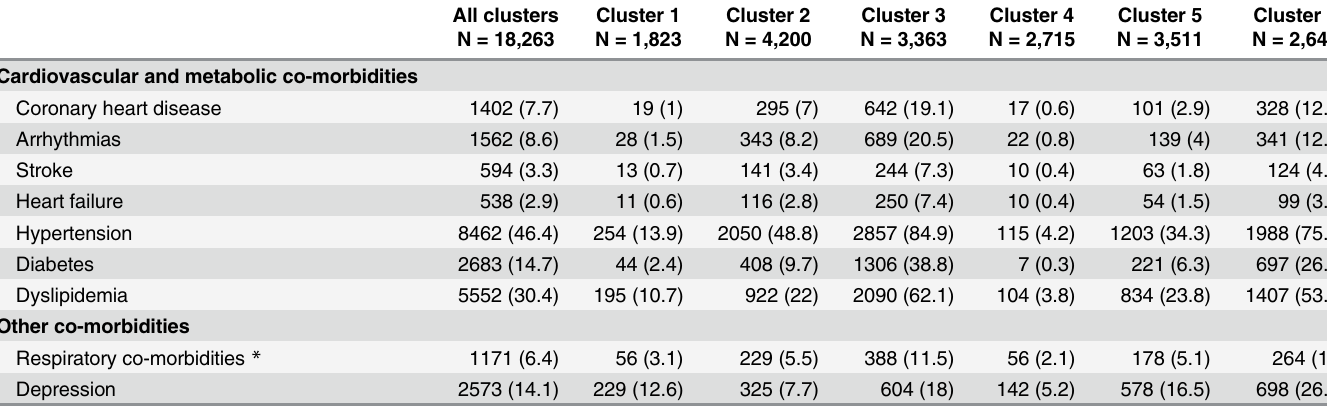
Table 2. Patients characteristics of the entire cohort and by clusters: Co-morbidities. Values in Numbers